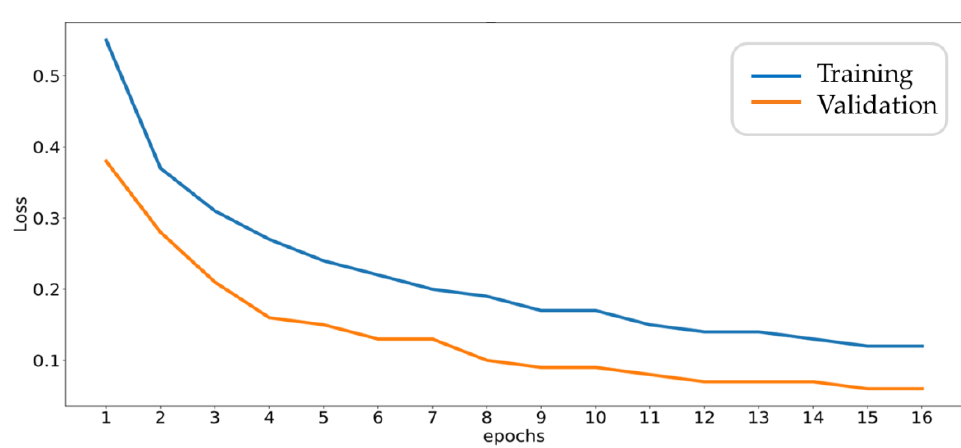
Figure 15. Loss trends during the training and validation process.